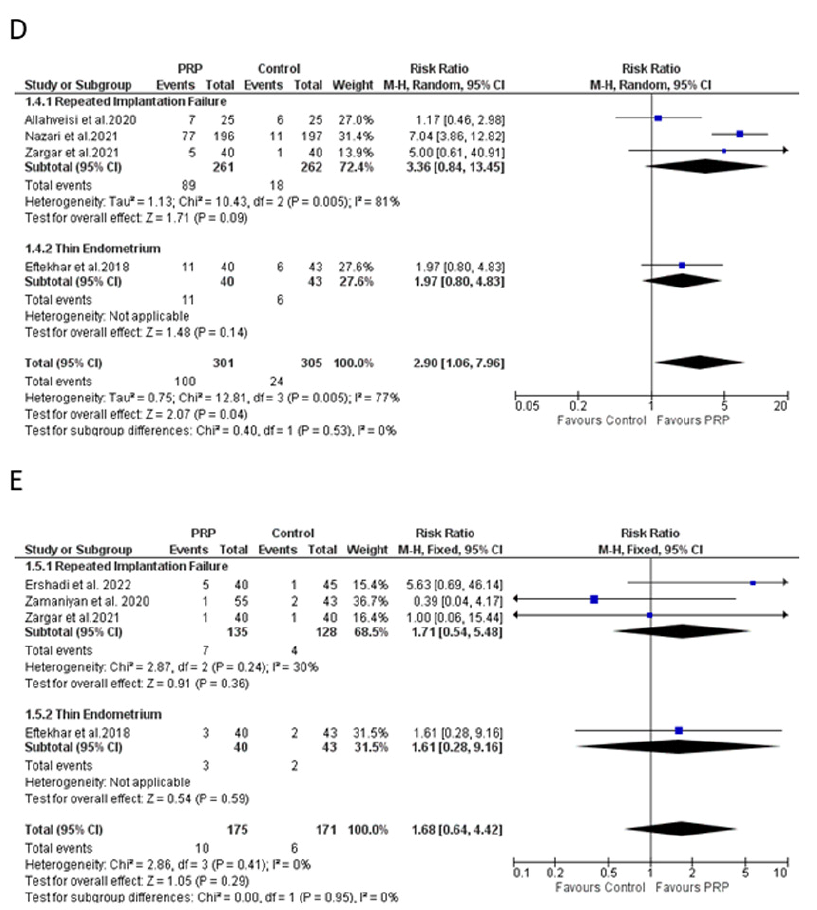
Figure 3. Meta-analysis of the studies evaluating ( A ) clinical pregnancy rate, ( B ) implantation rate, ( C ) biochemical pregnancy rate, ( D ) live-birth rate, and ( E ) miscarriage rate. CI: confidence interval; PRP: platelet-rich plasma. Studies with high-risk bias were excluded.